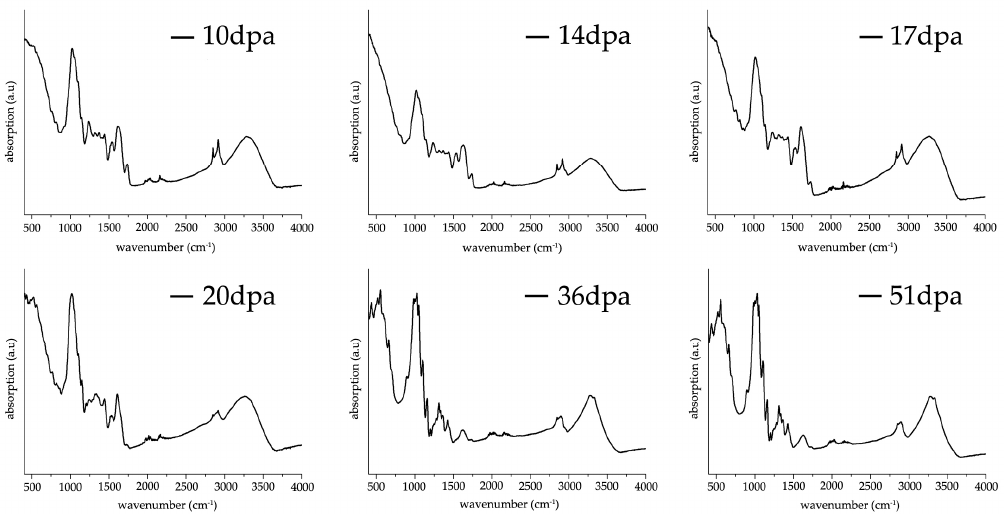
Figure 3. Representative fourier transform infrared spectroscopy with attenuated total reflectance (FT-IR ATR) spectra of raw/washed fibers of G. hirsutum harvested at different stages of development (10, 14, 17, 20, 36 and 51 dpa). The fibers were removed without stretching, washed in distilled water prior air-drying at room temperature and kept in a controlled humidity atmosphere (52% RH). Significant spectroscopic differences are observed at 17–20 dpa time threshold indicating that, at this point, the switch from primary to secondary cell wall occurs similarly to the soil-based cultures.